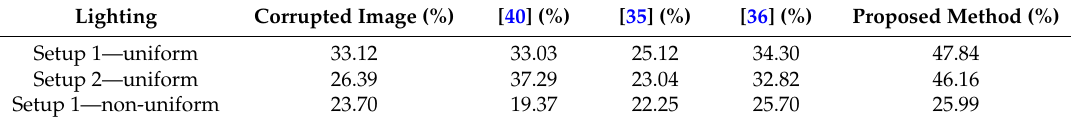
Table 2. Evalution of stereo vision from scatter-corrupted images; the stereo vision method is NSSD.